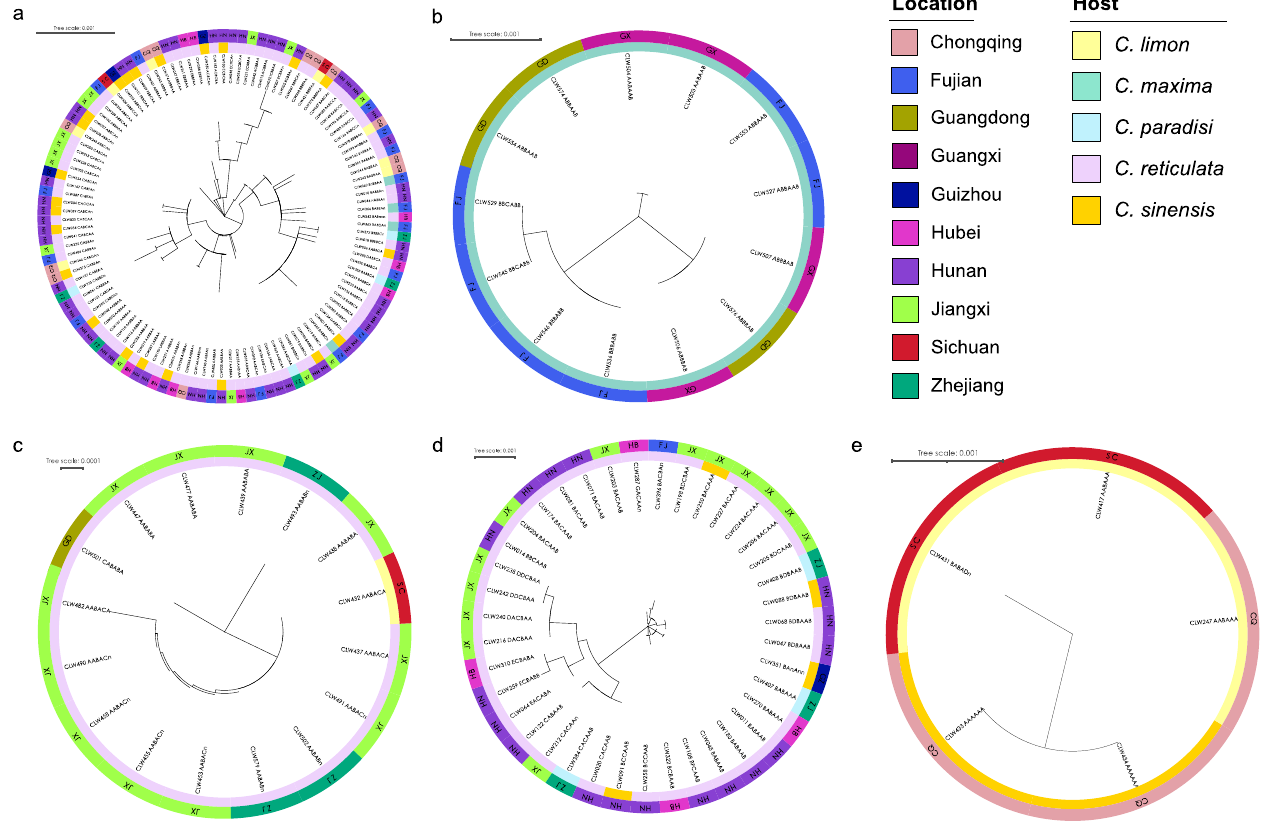
Figure 6. A maximum likelihood phylogenetic tree for each of five Phyllosticta species based on sequences at six loci in this study. ( a ) P. capitalensis , ( b ) P. citriasiana , ( c ) P. citricarpa , ( d ) P. citrichinaensis , ( e ) P. paracitricarpa . The colors of the outermost ring represent the sampling province and the inner color block represents the host tree. The annotation of the tree reflects the genotype and their distribution on location and host.